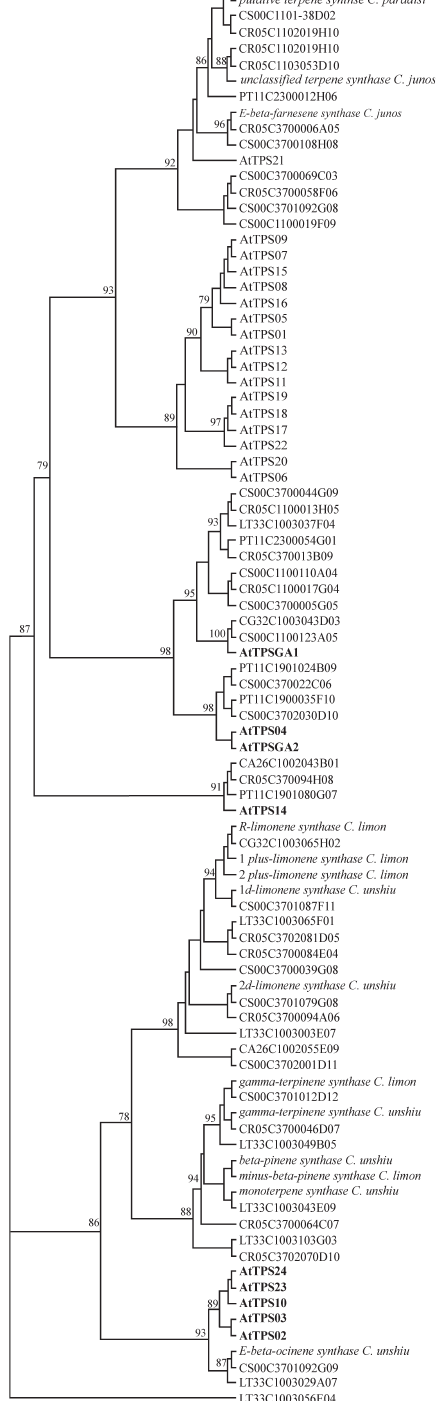
Figure2 -Phylogenetictreeofthe Citrus putativeterpenesynthasefamily members, the Arabidopsis terpene synthase family (AtPS) and representa- tive Citrus terpene synthases of known function. The neighbor-joining tree was generated from an alignment of amino acid sequences. Nodes supportedbybootstrapvalueshigherthan75%areshown.Fordesignation of the AtTPS genes see Aubourg et al. (2002). For characterized Citrus se- quences see Sharon-Asa et al. (2003) and Shimada et al. (2004; 2005). CA: Citrus aurantium ; CG: C. aurantifolia ; CR: C. reticulata ; CS: C. sinensis , LT: C. latifolia ; PT: Poncirus trifoliata . Shadowed sequences contain predicted signaling peptides directing them to the